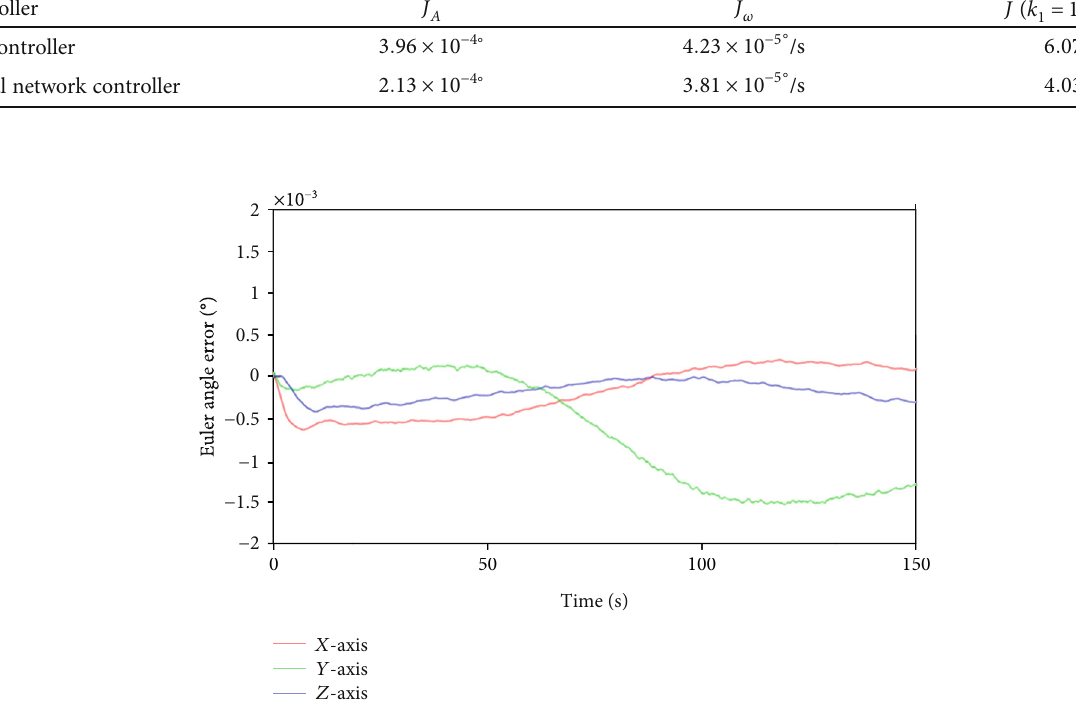
Figure 6: Euler angle error of the PID controller with the optimal coe ffi cient